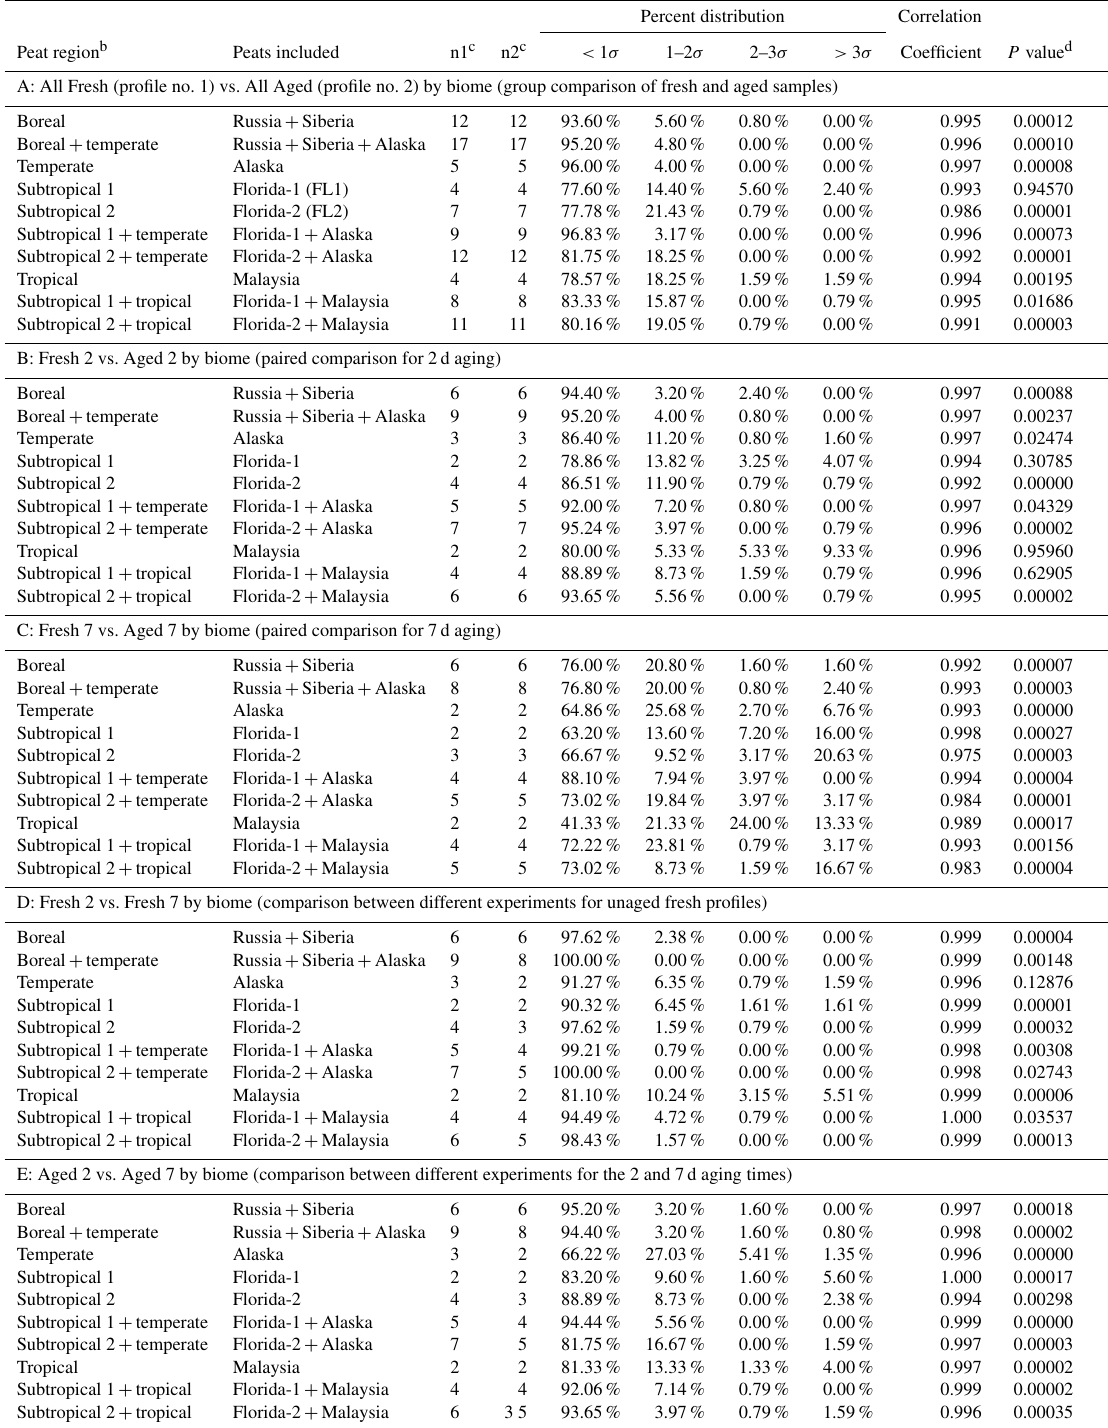
Table 2. Equivalence measures a for comparison of PM 2 . 5 peat source